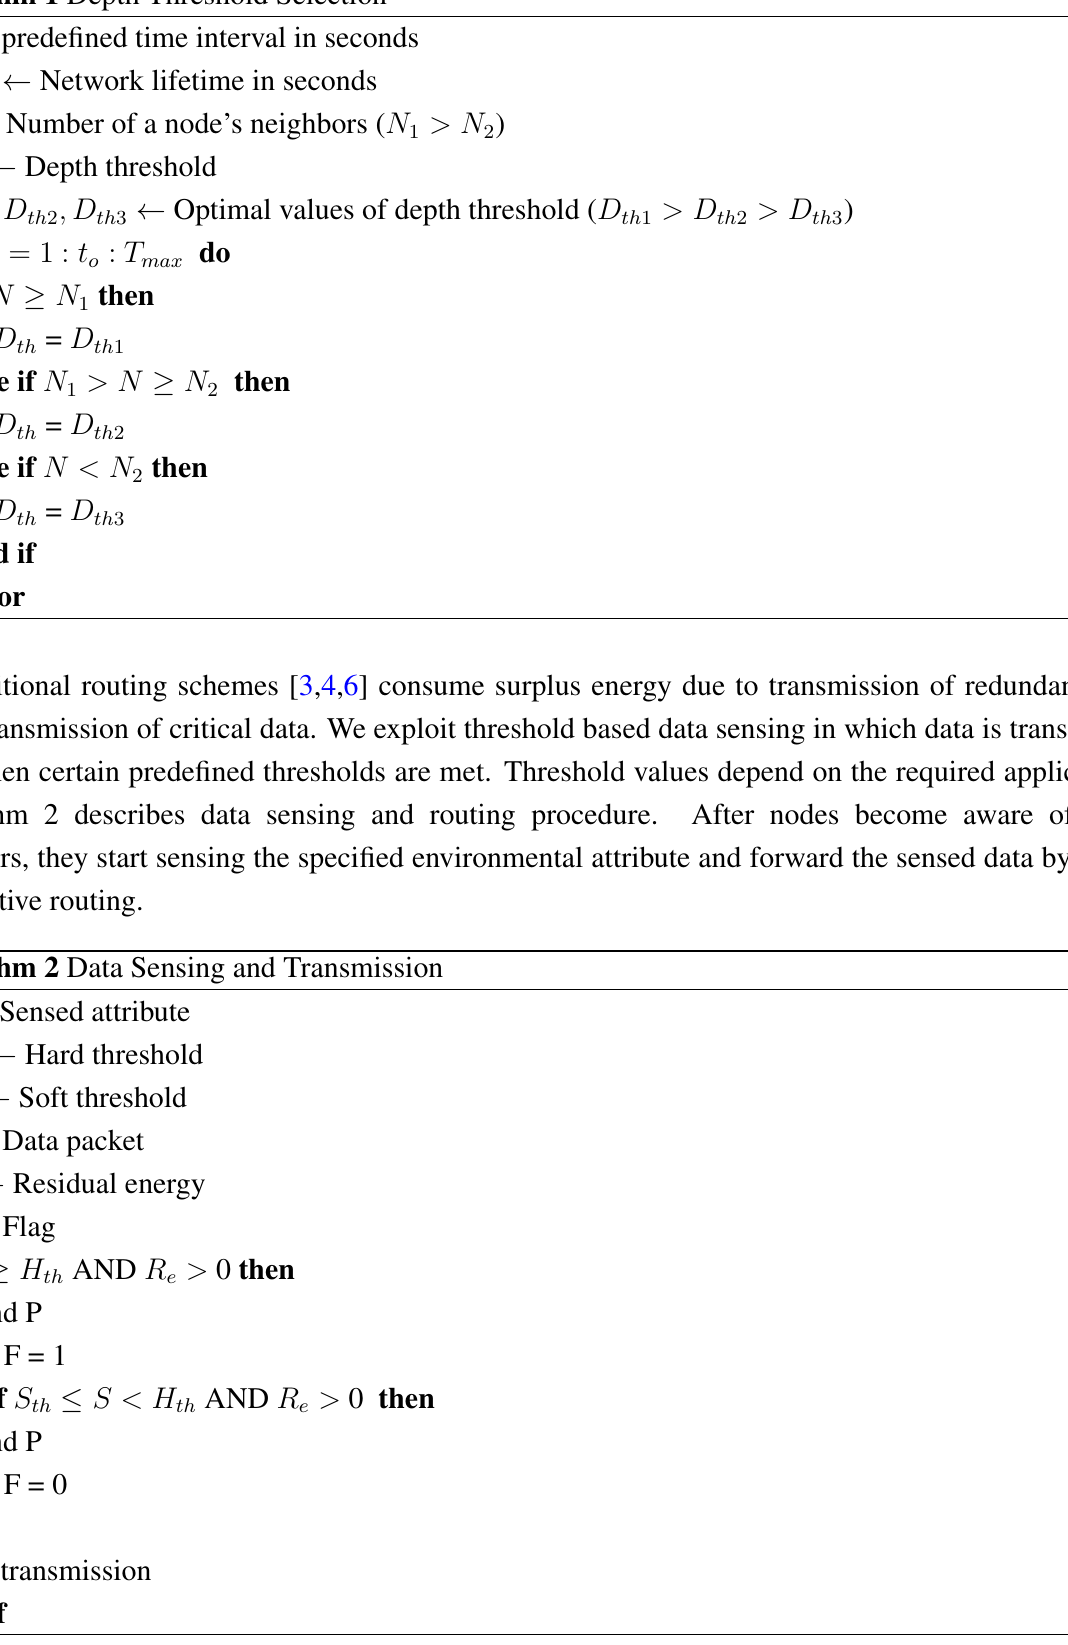
Algorithm 1 Depth Threshold Selection